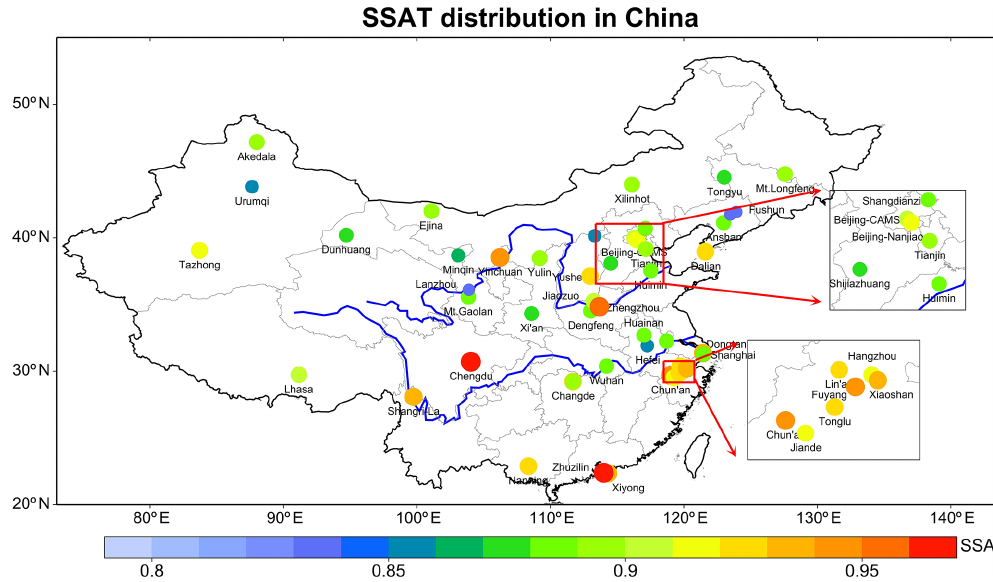
Figure 5. Annual spatial distribution of the single-scattering albedo (SSA) at 440nm at the CARSNET